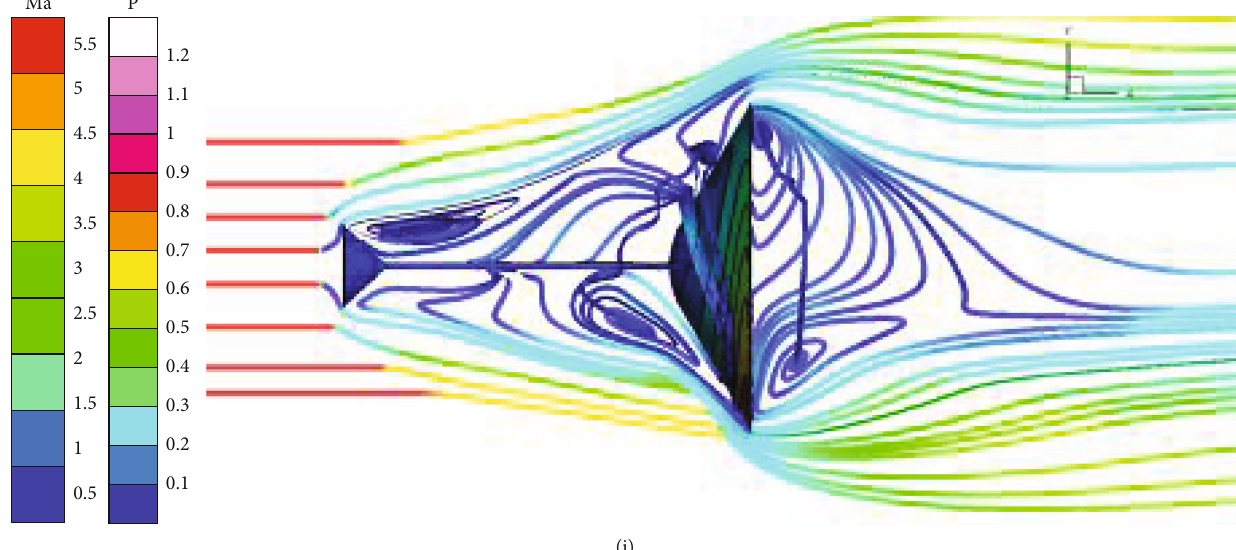
Figure 7: Instantaneous streamline (stained by Mach number) and wall pressure contour of forced-pitching oscillation. (a) Pitch angle 0 ° ; phase angle 0 ° . (b) Pitch angle 7.7 ° ; phase angle 22.5 ° . (c) Pitch angle 14.1 ° ; phase angle 45 ° . (d) Pitch angle 18.5 ° ; phase angle 67.5 ° . (e) Pitch angle 20 ° ; phase angle 90 ° . (f) Pitch angle 18.5 ° ; phase angle 112.5 ° . (g) Pitch angle 14.1 ° ; phase angle 135 ° . (h) Pitch angle 7.7 ° ; phase angle 157.5 ° . (i) Pitch angle 0 ° ; phase angle 180 °